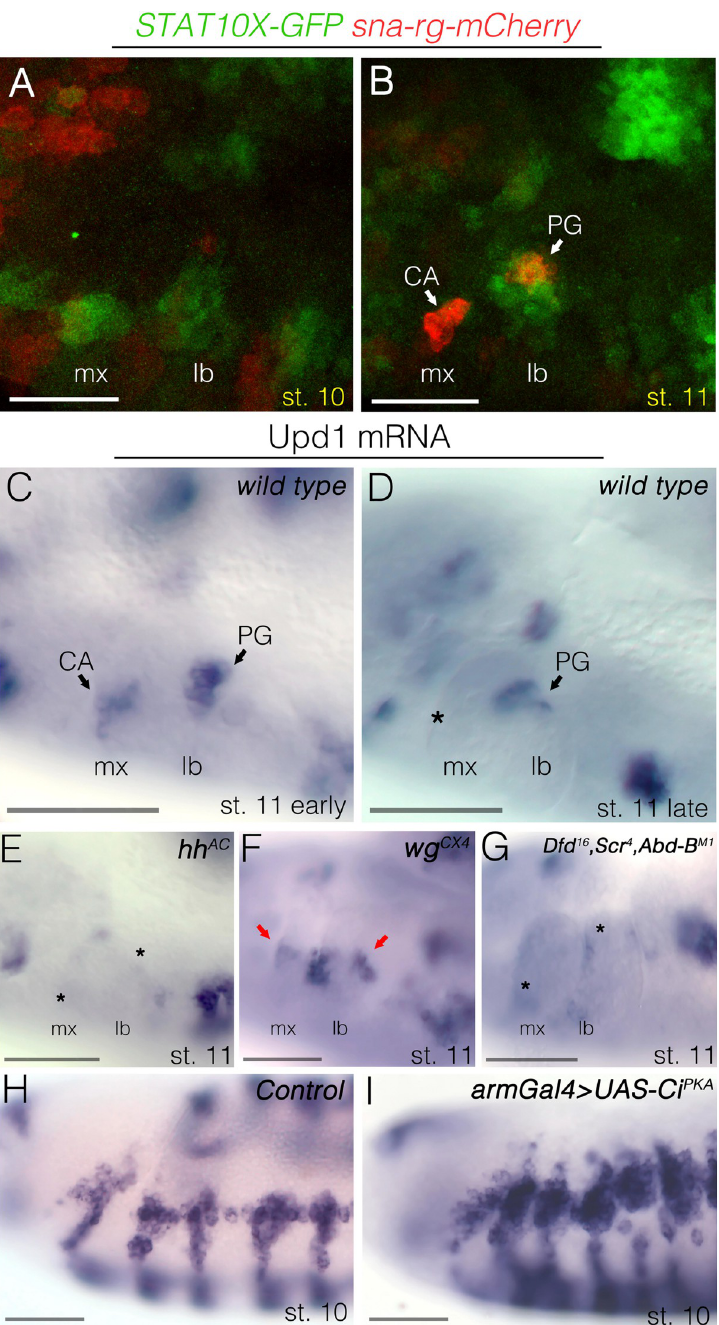
Fig 4. JAK/STAT pathway requirement for gland specification. (A-B) Wild type embryos carrying the sna-rg- mCherry (red) and 10xSTAT-GFP (green) reporter genes. (A) At st10, embryos present patches of green staining in the maxillary and labial segments at the position where the gland primordia will become activated. Weak sna-rg expression starts to appear. (B) At st11, when sna-rg-mCherry is strongly activated, 10xSTAT-GFP expression has faded from the maxilla while is maintained in the labium. Note that 10xSTAT-GFP expression is also activated in the tracheal primordia. (C-I) upd mRNA in situ hybridization in st10-st11 embryos. (C) A wild type early st11 embryo showing upd mRNA in the maxillary and labial segments is restricted to two patches where the CA and the PG form. (D) At late st11, upd mRNA expression only remains in the PG (asterisk marks the position where the CA primordium is located). (E) hh null mutants lose maxillary and labial upd transcription (asterisks), which remains in the tracheal primordia. (F) In wg null mutants, upd transcription is extended in the maxillary and labial segments (arrows), as well as